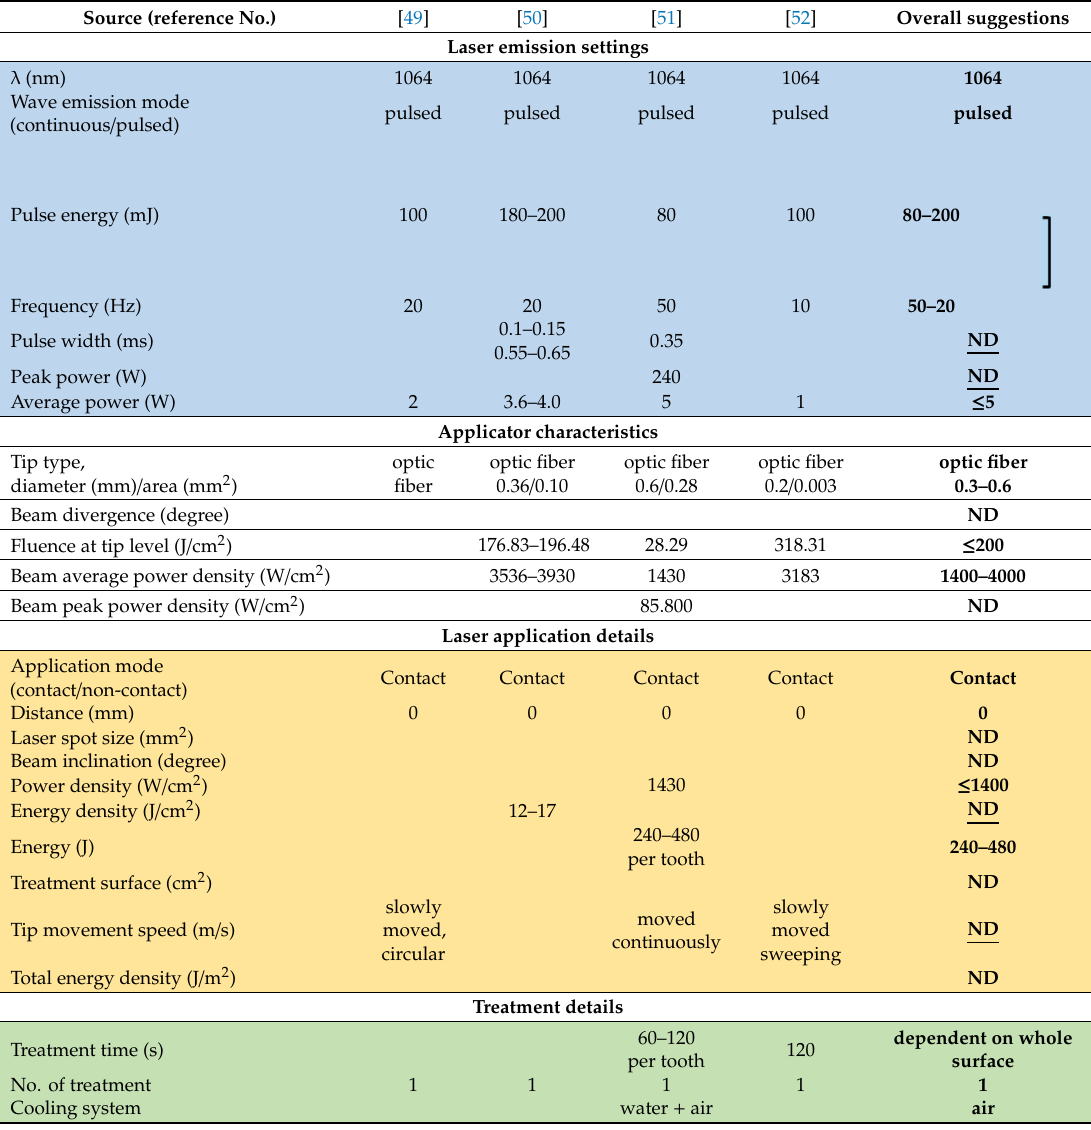
Table 2. Suggested parameters for photoablative Nd:YAG laser.